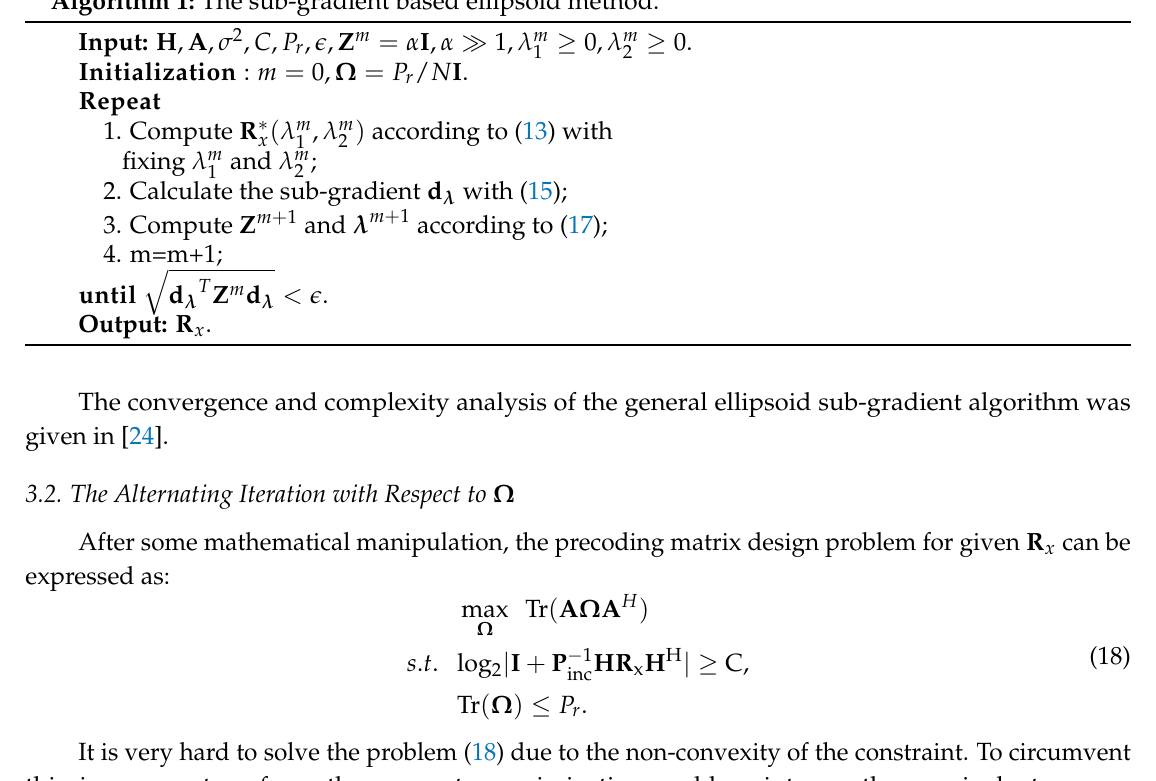
Algorithm 1: The sub-gradient based ellipsoid